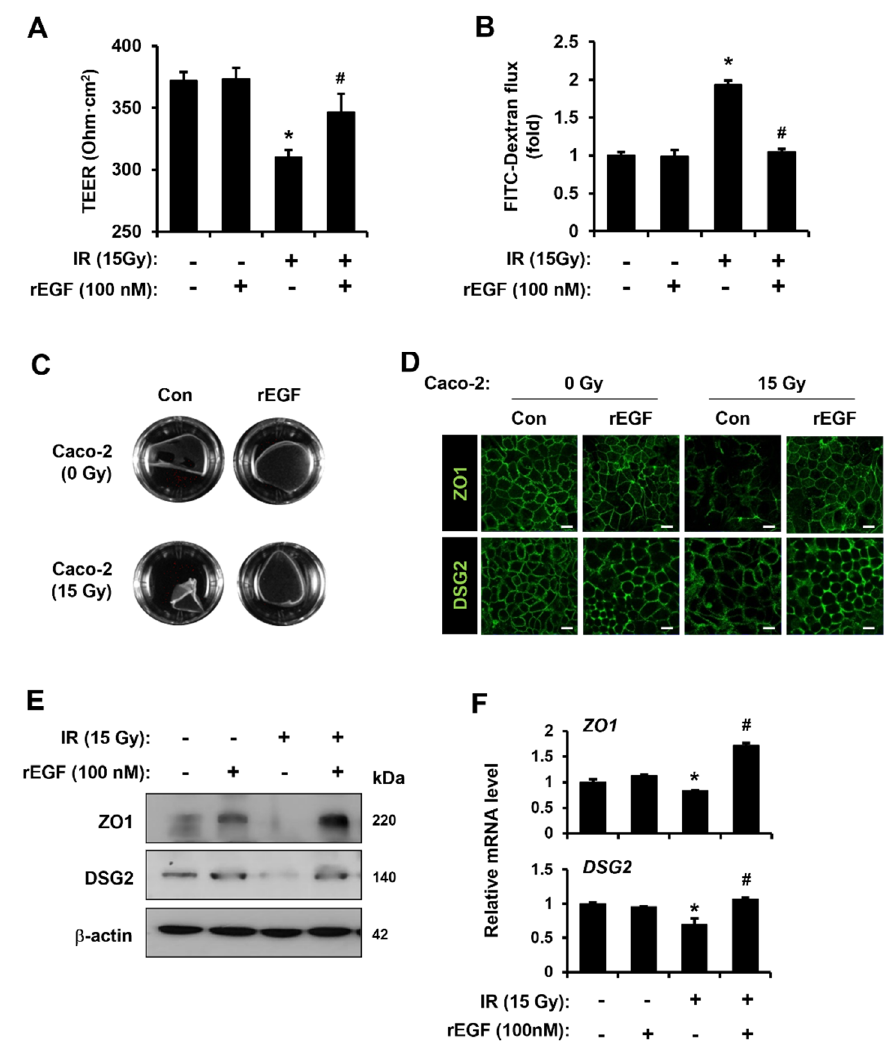
Figure 5. Epidermal growth factor restores radiation-induced epithelium barrier dysfunction with upregulation of ZO1 and DSG2. ( A ) Transepithelial electrical resistance (TEER) values of Caco- 2 monolayers were determined after treatment with recombinant epidermal growth factor (rEGF; 100 nM). ( B ) The flux of FITC-dextran was measured using a microplate fluorescence reader (excitation at 450 nm and emission at 520 nm). The graph is shown as a fold of fluorescence normalized to control group. ( C ) The activity of dispase-based dissociation in Caco-2 monolayers with or without rEGF was observed. ( D ) The zonula occludens 1 (ZO1) and desmoglein 2 (DSG2) intensities of Caco-2 monolayers were observed using a confocal laser scanning microscope. ( E ) Protein levels of ZO1 and DSG2 were determined by western blot analysis. ( F ) mRNA levels of ZO1 and DSG2 were measured by qRT-PCR. Data are presented as the mean ± standard deviation of the mean; n = 3, * p < 0.05 compared to the Con group; # p < 0.05 compared to the IR group. Scale bars represent 10 µ m. All data represent at least two independent